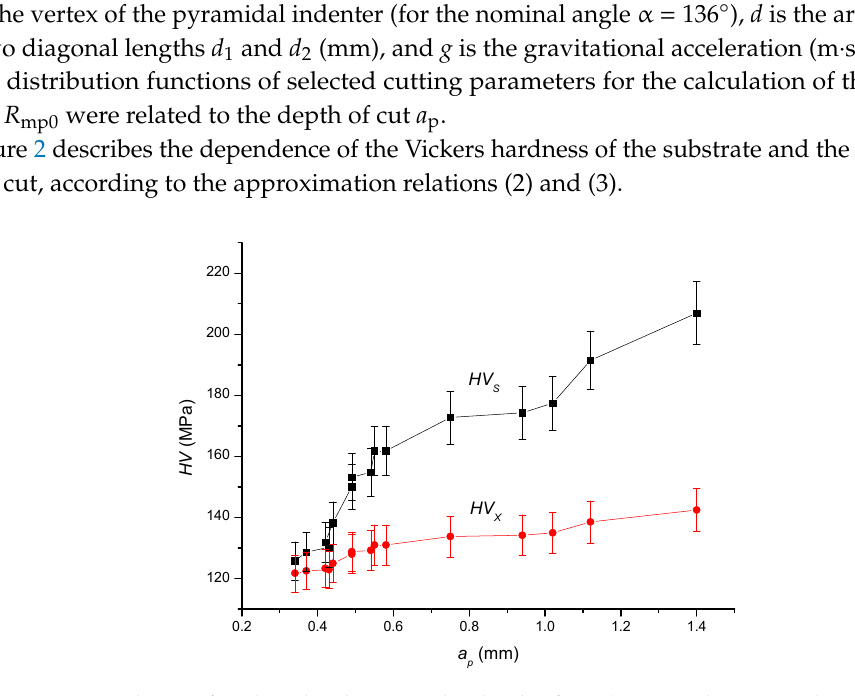
Figure 2. Dependence of Vickers hardness on the depth of cut ( HV S —substrate Vickers hardness; HV X —spray Vickers hardness).